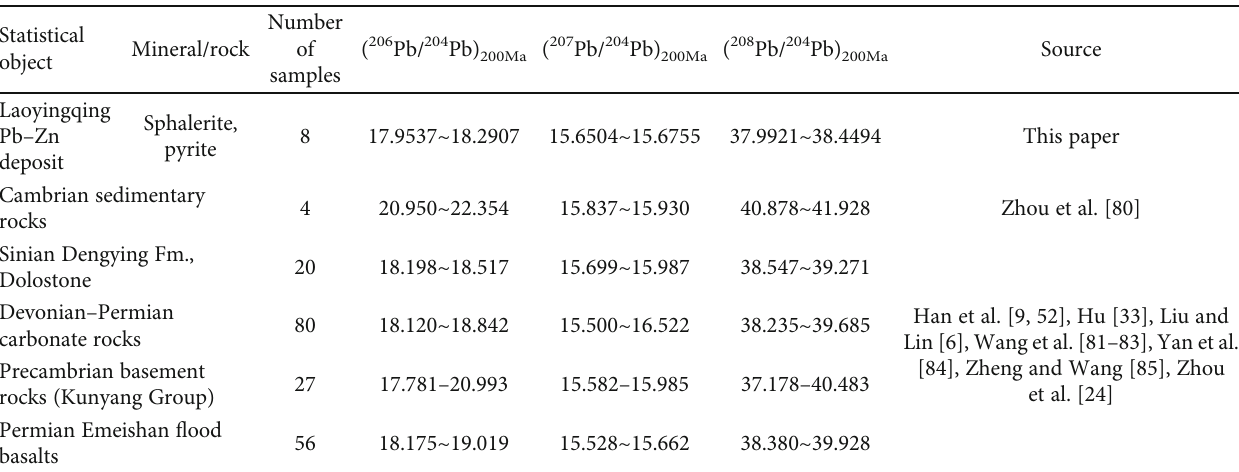
Table 6: Statistical results of the Pb isotope compositions of the Laoyingqing Pb – Zn deposit, Sinian dolomite, Cambrian sedimentary rocks, Devonian to Permian carbonate rocks, Precambrian basement rocks (Kunyang Group), and Permian Emeishan fl ood basalts.